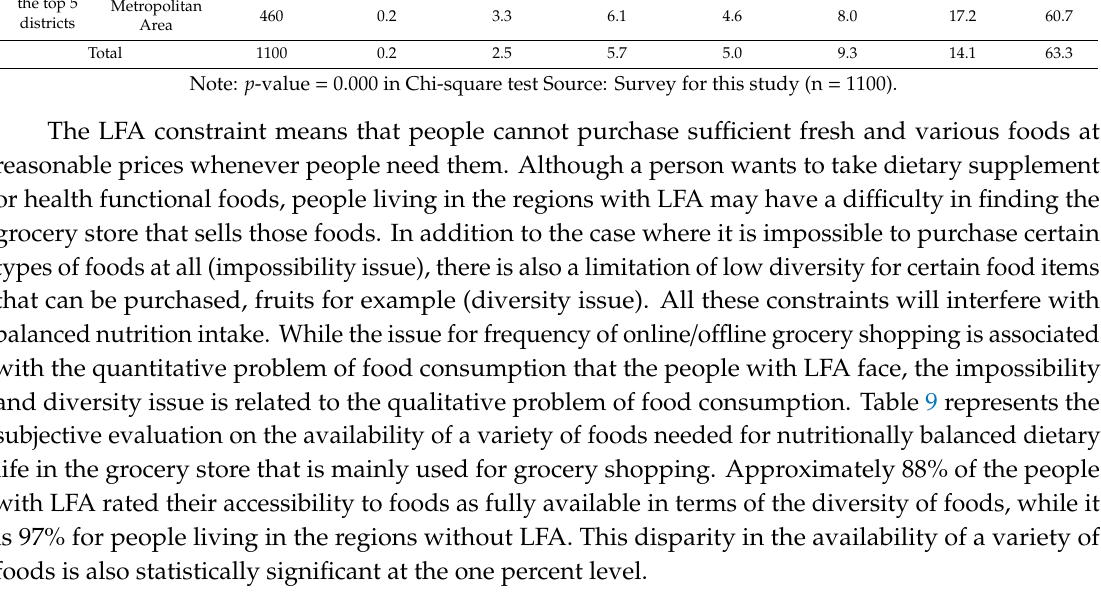
Table 8. Frequency of grocery shopping via online: administrative districts with and without LFA. Frequency of Grocery Shopping Via Online (%) Number of / Two / Month Less Than Respondents Once / Day 2–3 Times / Day Once / Week Once Weeks Once Once / Month Never Top 5 lower-level districts with LFA 100 0.0 1.0 6.0 9.0 73.0 Lower-level Rural Area 100 districts other than Urban Area 440 the top 5 districts